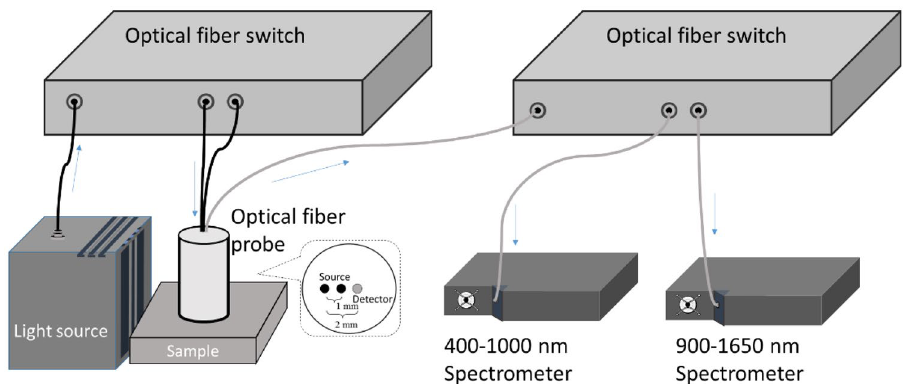
Figure 5. Schematic of the DRS system. Two optical switches were used in the system where one was used for switching light source to one of the two source fibers, and the other was used to switch the collected light signal to one of the two spectrometers. The fiber setup of the optical probe is shown in the